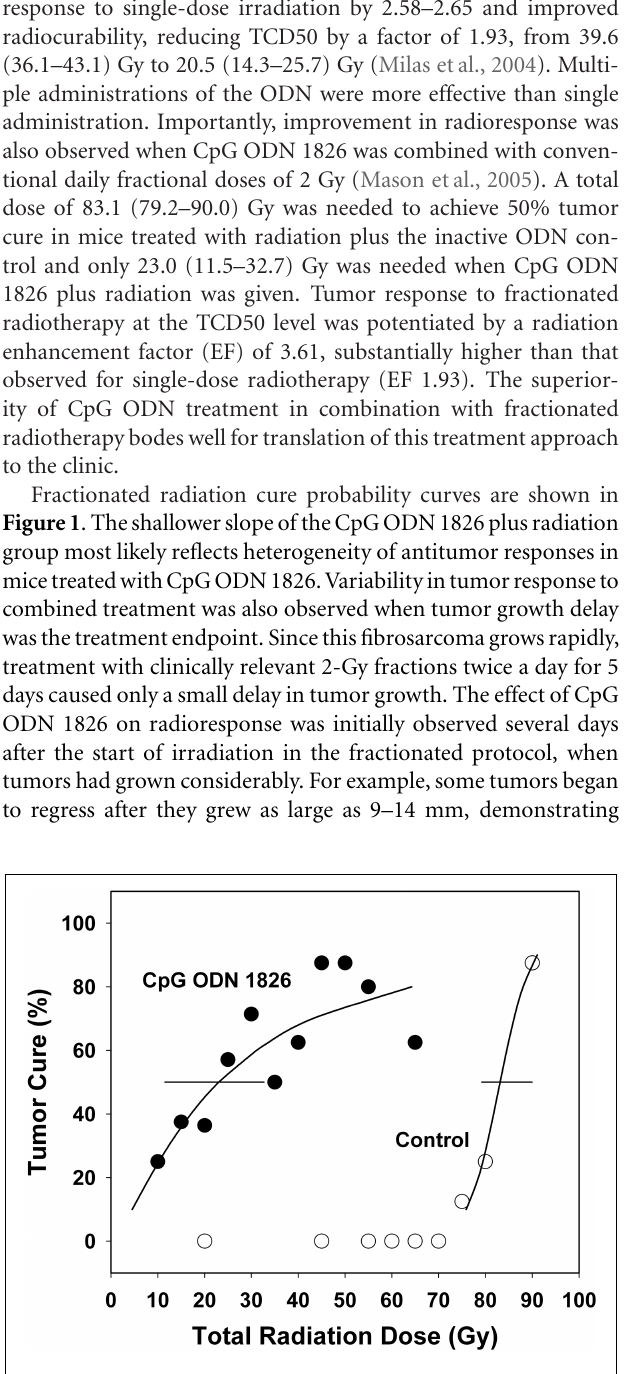
FIGURE 1 | Effect of CpG ODN 1826 on tumor radiocurability. Percentage of tumor cures was plotted as a function of radiation dose. Mice bearing FSa tumors in the leg were exposed to a range of fractionated doses when tumors reached 8 mm in diameter and treated seven times • ◦ with the active CpG ODN 1826 ( ) or the inactive ODN 2138 ( ), at a dose of 100 μ g per mouse given s.c. peritumorally, when tumor diameters were 6 and 8 mm and once weekly for five additional weeks.TheTCD50 was determined at 100 days after irradiation. Horizontal bars , 95% confidence intervals. Reprinted by permission from the American Association for Cancer Research (Mason etal.,